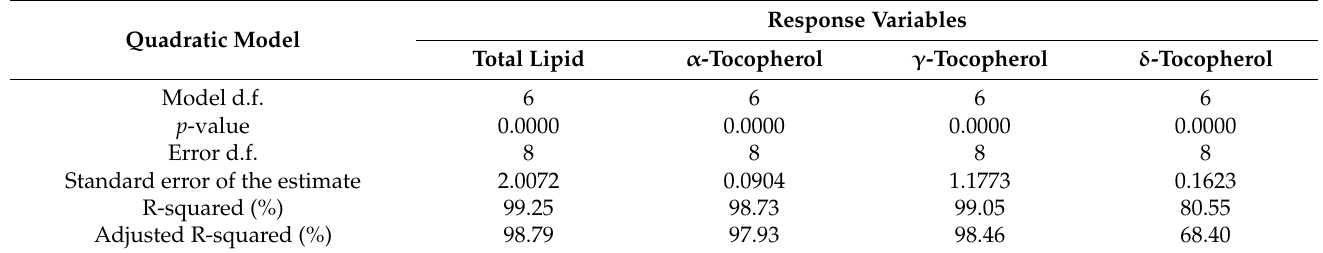
Table 3. ANOVA application of the simplex-lattice mixture design of fitting model to response variables (total lipid values and contents on α -, γ -, and δ